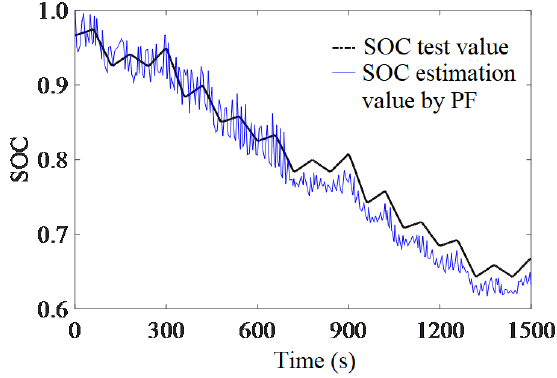
Figure 10. Comparison of SOC between PF estimation and test.